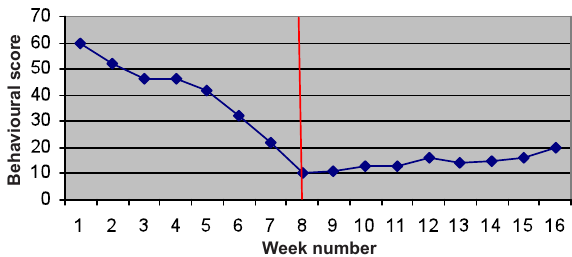
Figure 2. Behavioural scores of H . The weeks which show 2 the lowest score for H are between the 8 th and 9 th weeks 2 In this case the antler was cast off during the 8 th week (vertical red line). The behavioural score was 42.85±12.58 during the hard antler stage and it reduced to 12.6±2.3 during the velvet period.